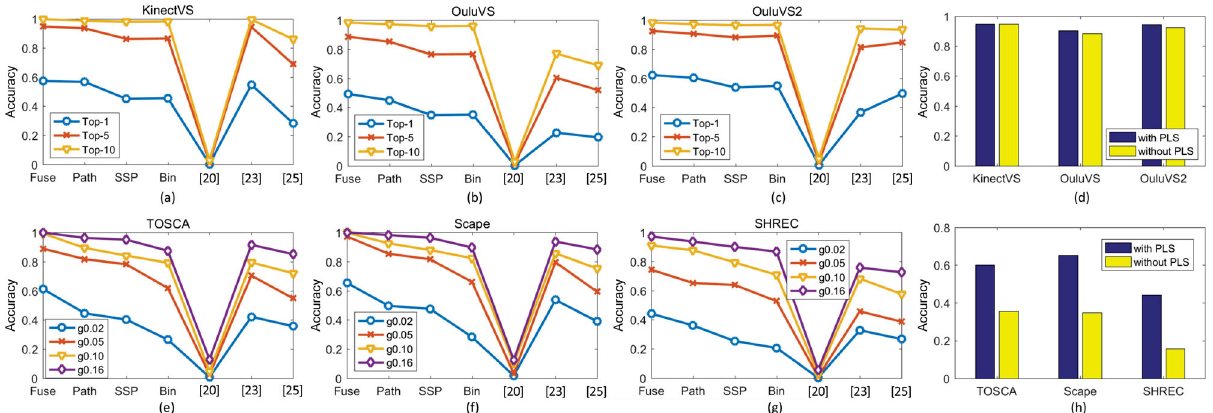
Fig. 6 Labeling accuracies for the combined random-forest-based metric (Fuse), the binary (Bin), common-path-based (Path), and SSP-based metrics, random forests with node splitting criterion using the determinant of the covariance matrix [20], the variance of feature differences [23], and the Gini index [25] on (a) KinectVS, (b) OuluVS, (c) OuluVS2, (e) TOSCA, (f) Scape, and (g) Shrec-NonSym datasets. The Top-5 and g0.02 accuracies with and without PLS on facial trajectories and 3D points are shown in (d) and (h) respectively.